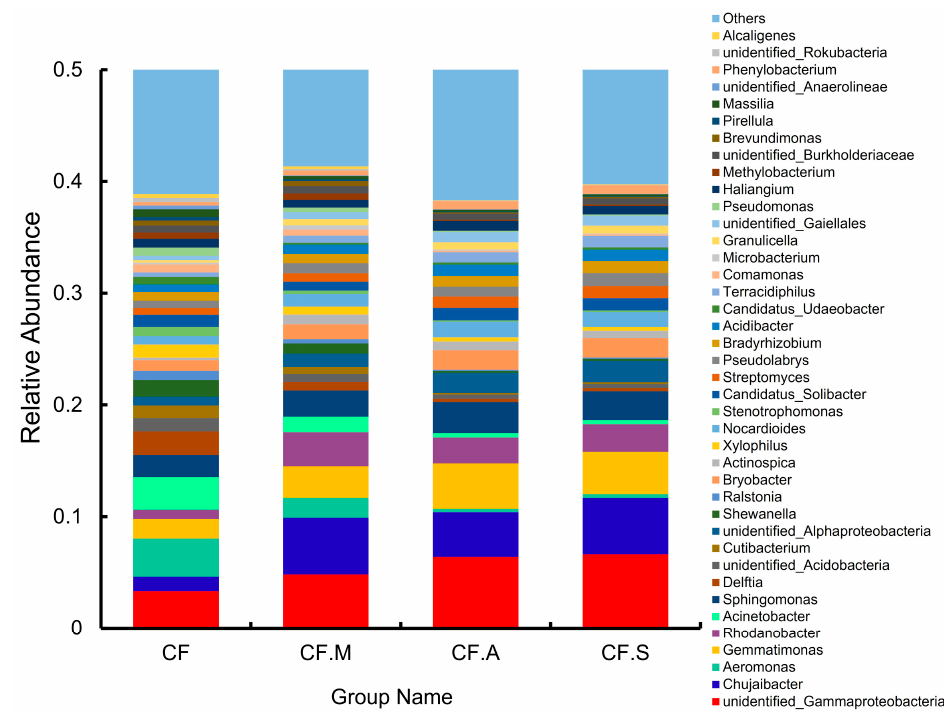
Figure 8. The relative abundance of top40 genera in the CF group.